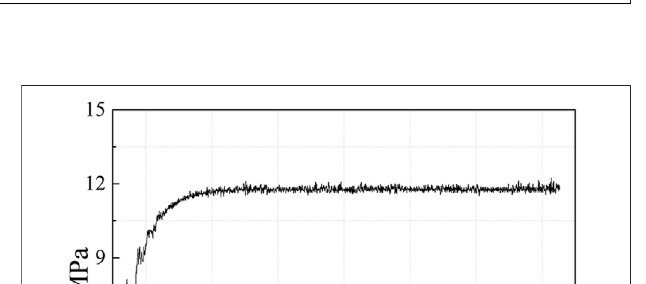
FIGURE 4 | Traveling wave 1T vibration mode structure.